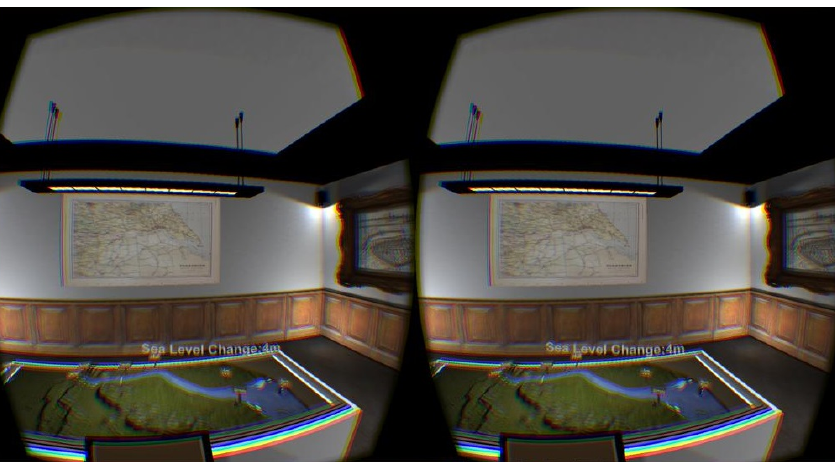
Figure 1. Screenshot from Humber in a Box showing left- and right-eye views. Inside the virtual reality headset these views appear as one, giving the illusion of a 3-D space. The scene on the table is a visualisation of the CAESAR-Lisflood model simulating tides in the Humber estuary,